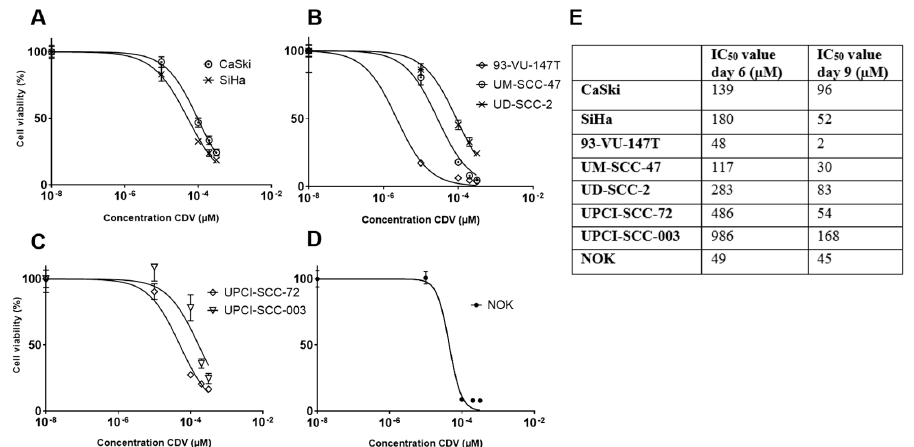
Figure 1. Effect of CDV on cell viability. The viability of the used cell lines was assessed using an MTT assay. The IC 50 value is the drug dose that causes 50% growth inhibition. Showing the results of 9 days CDV treatment: ( A ) HPV-positive UCC cell lines, ( B ) HPV-positive HNSCC cell lines, ( C ) HPV-negative HNSCC cell lines, ( D ) NOK cell line, ( E ) Overview of IC 50 values after 6 and 9 days of treatment. The experiments were performed in